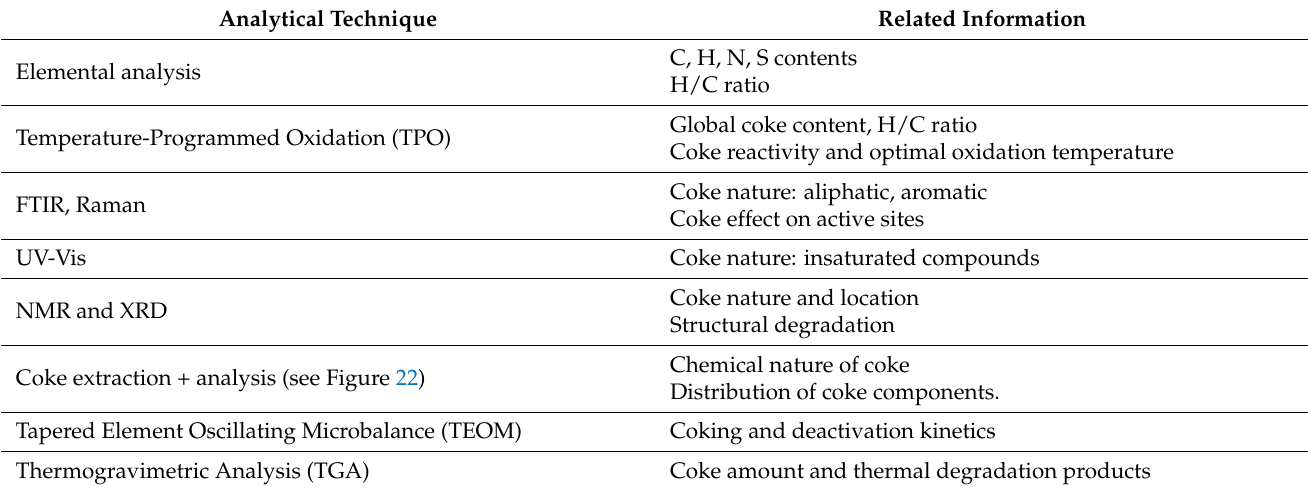
Table 7. Principal analytical techniques used for the analysis of deactivating species over solid